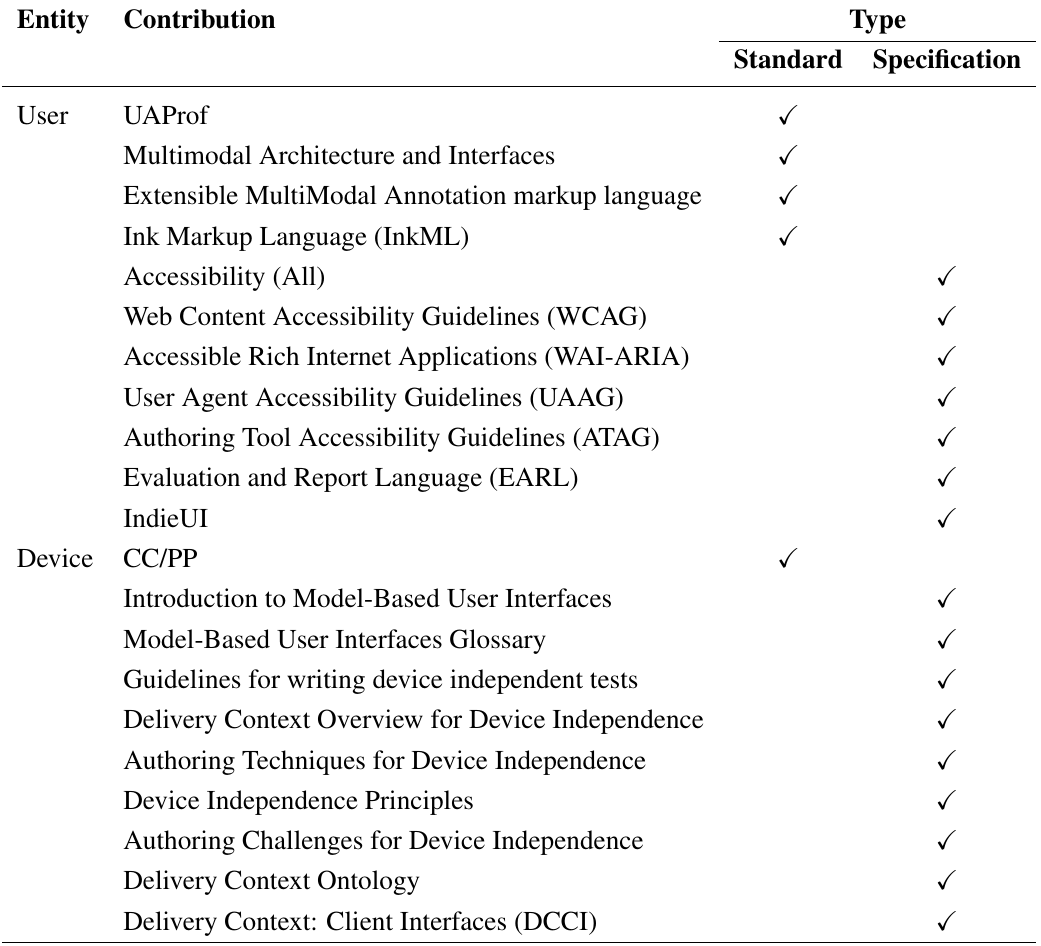
Table 5. W3C standards and specifications for user and device